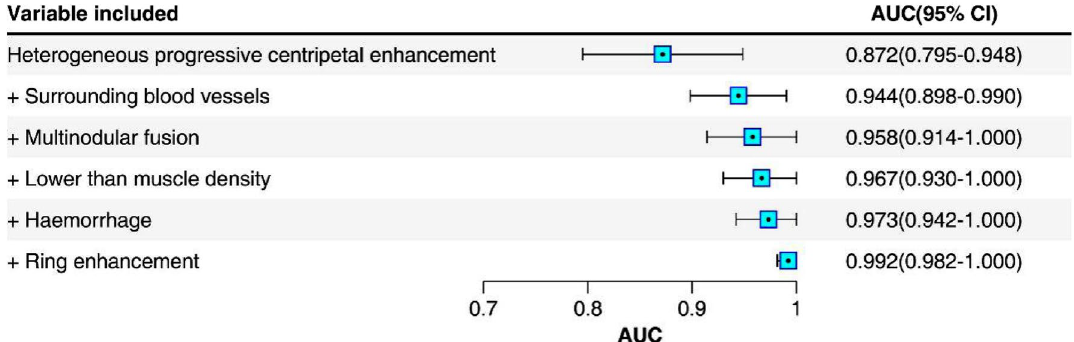
Figure 4. AUC of fisher’s discriminant model and its 95% CI accumulated according to the importance of the features. CI confidence interval, AUC area under the